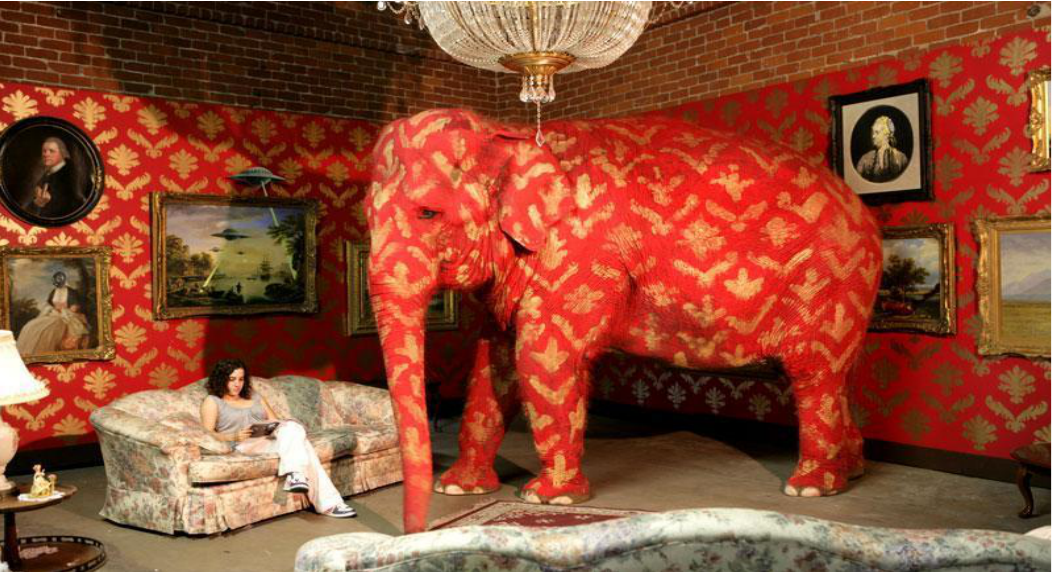
Figure 1. Photograph of ‘ The Elephant in the Room ’ installation by Banksy (Los Angeles, 2006). Source: